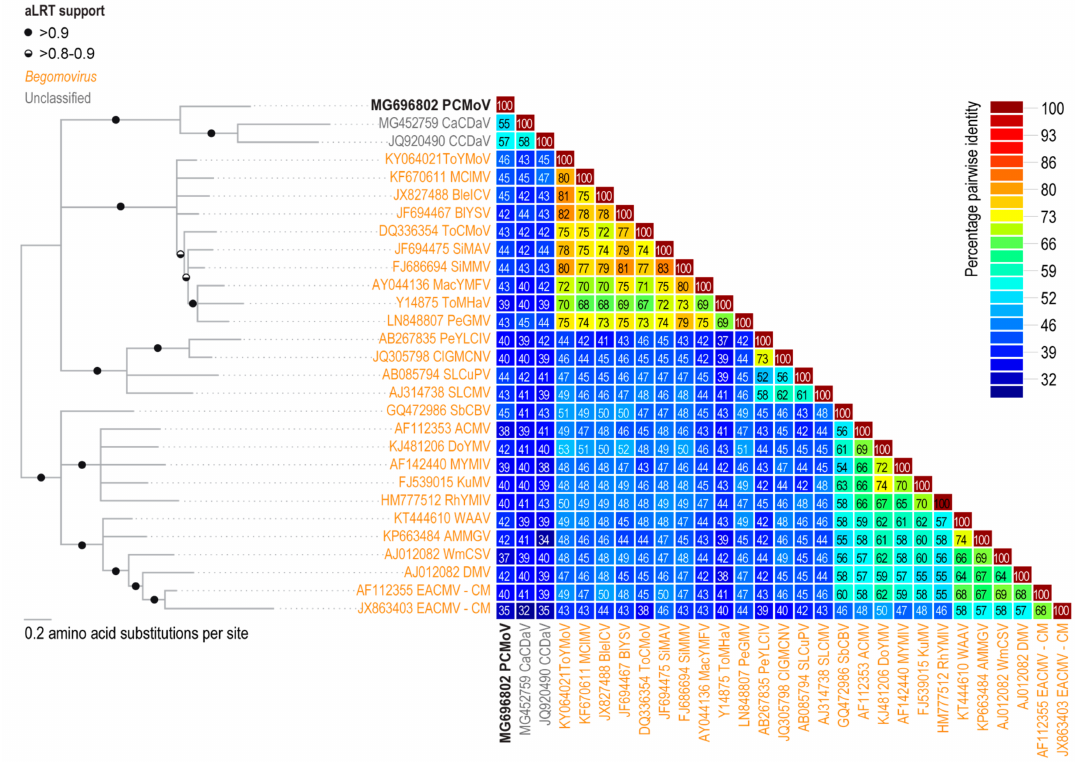
Figure 3. Midpoint rooted Maximum likelihood phylogenetic tree inferred using the substitution model rtREV+G for the MP amino acid sequences and aLRT test for branch support coupled with percentage pairwise identity matrix of the MP amino acid sequences. The sequences used for both analysis are those encoded by the following: African cassava mosaic virus (ACMV), asystasia mosaic Madagascar virus (AMMGV), blainvillea yellow spot virus (BlYSV), blechum interveinal chlorosis virus (BleICV), CaCDaV, CCDaV, clerodendrum golden mosaic China virus (ClGMCNV), deinbollia mosaic virus(DMV), dolichos yellow mosaic virus (DoYMV), East African cassava mosaic virus-Cameroon (EACMV-CM), Kudzu mosaic virus (KuMV), macroptilium yellow mosaic Florida virus (MacYMFV), melon chlorotic mosaic virus (MClMV), mungbean yellow mosaic India virus (MYMIV), PCMoV, pepper golden mosaic virus (PeGMV), pepper yellow leaf curl Indonesia virus (PeLCIV), rhynchosia yellow mosaic India virus (RhYMIV), sida micrantha mosaic virus (SiMMV), sida mosaic Alagoas virus (SiMAV), soybean chlorotic blotch virus (SbCBV), squash leaf curl Philippines virus (SLCuPV), Sri Lankan cassava mosaic virus (SLCMV), tomato chlorotic mottle virus (ToCMoV), tomato mosaic Havana virus (ToMHaV), ToYMoV, watermelon chlorotic stunt virus (WmCSV), and West African asystasia virus